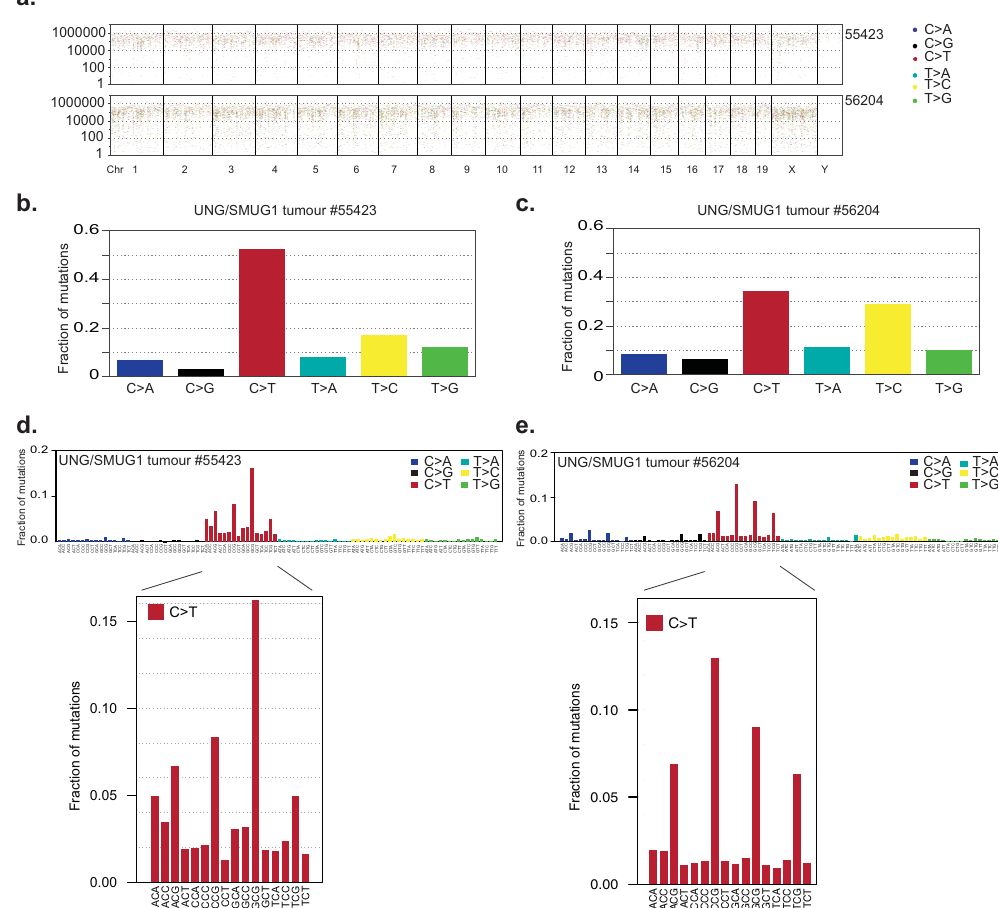
Figure 3. Mutational landscape of UNG/SMUG1 double knockout tumour. Whole genome sequencing was performed to assess the mutational profiles in tumour arising spontaneously in UNG/SMUG1 double knockout mice. ( a ) Rainfall plots showing the distribution of mutations in tumours from two different mice (denoted 55423 or 56201) along each chromosome. Each dot represents one variant and the distance between mutations are indicated. ( b , c ) The types of base pair changes represented as the fraction of the total variant observed. ( d , e ) Trinucleotide plots summarising the sequences surrounding each variant normalised to genomic trinucleotide occurrence. The sequence context of all mutations occurring at C:G base pairs is magnified